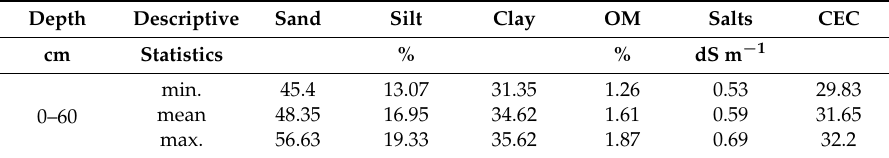
Table 1. Soil samples collected at 0–60 cm soil depth with the minimum, mean and maximum values for sand, silt, clay, pH, organic matter, soluble salts, and cation exchange